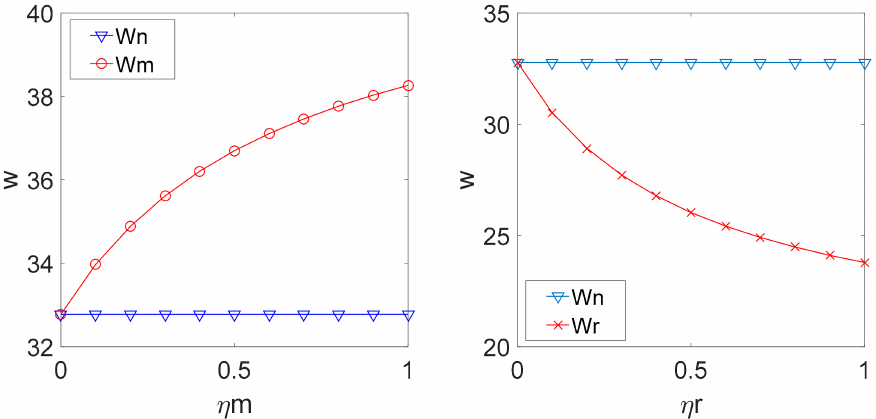
Figure 2. Relationship among η m , η r and w